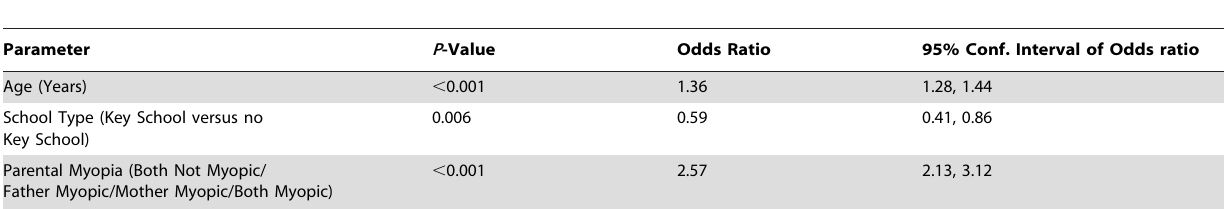
Table 6. Results of the multivariate analysis of the prevalence of myopia (defined as refractive error #2 8.00 diopters in the worse eye) and ocular and systemic parameters in the Beijing Pediatric Eye